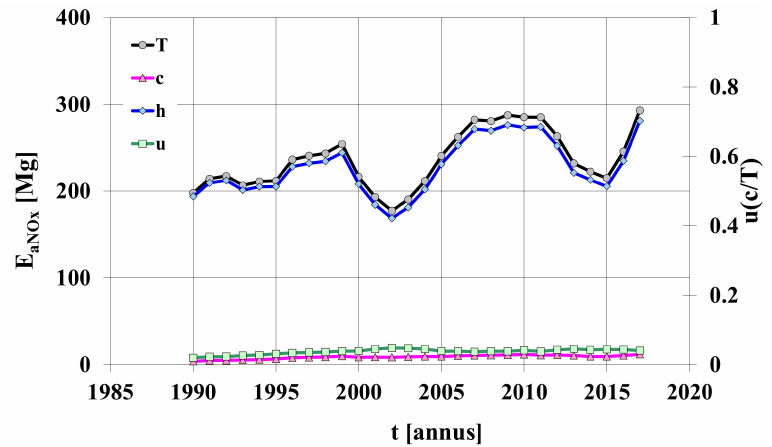
Figure 3. Annual emission of nitrogen oxides—E aNOx : national (total)—T, from car engines at cold-start—c, from car engines at warm-up—h and the share of additional emissions during engine heating in total emissions—u(c/T).